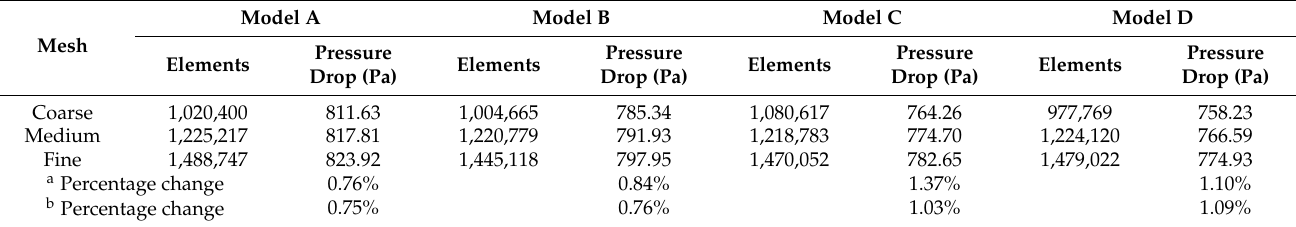
Table 3. Mesh independence study for cyclone